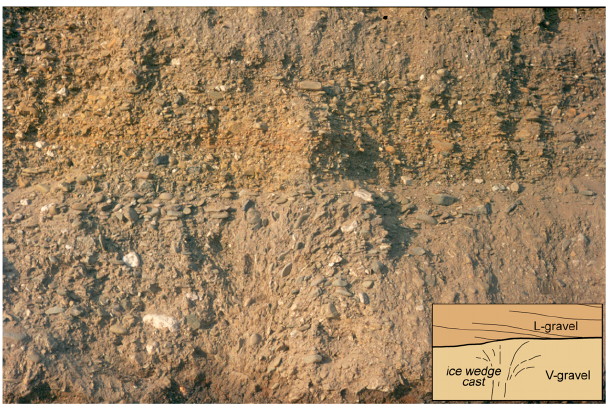
Figure 19. The lateral accretion gravel (L ‐ gravel) of the Holocene Zettlitz Flument overlies Figure 19. unconformably the vertical aggradation gravel (V ‐ gravel) of the Late Pleistocene Reundorf Flument that includes an ice wedge cast (Photo: W. Schirmer, 12 October 1972).